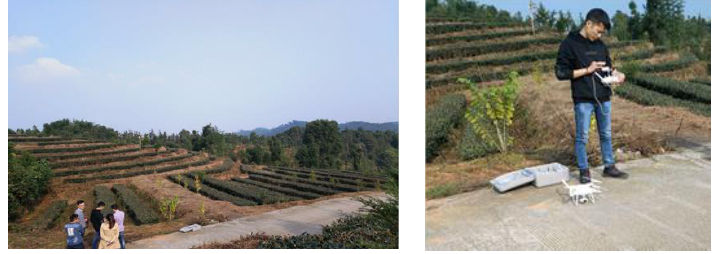
Figure 1. Photograph of the tea garden and the drone operator.